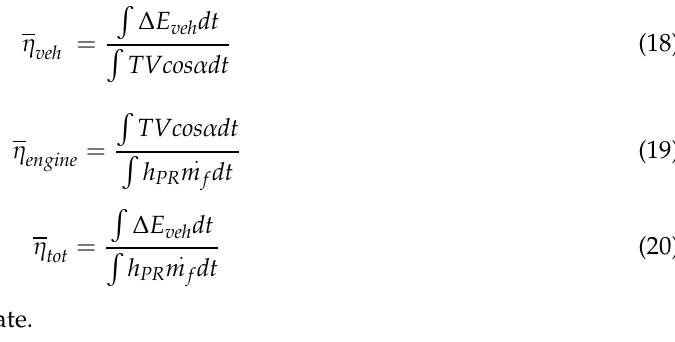
Figure 8. ( a ) Vehicle efficiency profiles; ( b ) Engine efficiency profiles; ( c ) Total efficiency profiles.